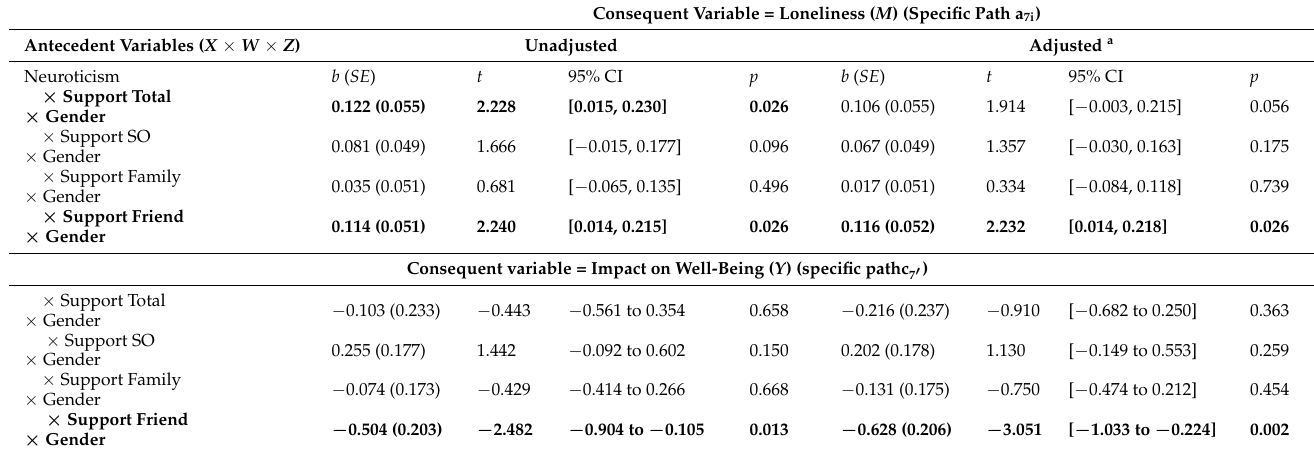
Table 4. Coefficients Across Models for Moderation Effects of Support × Gender on Specific Paths. Consequent Variable = Loneliness ( M ) (Specific Path a 7i